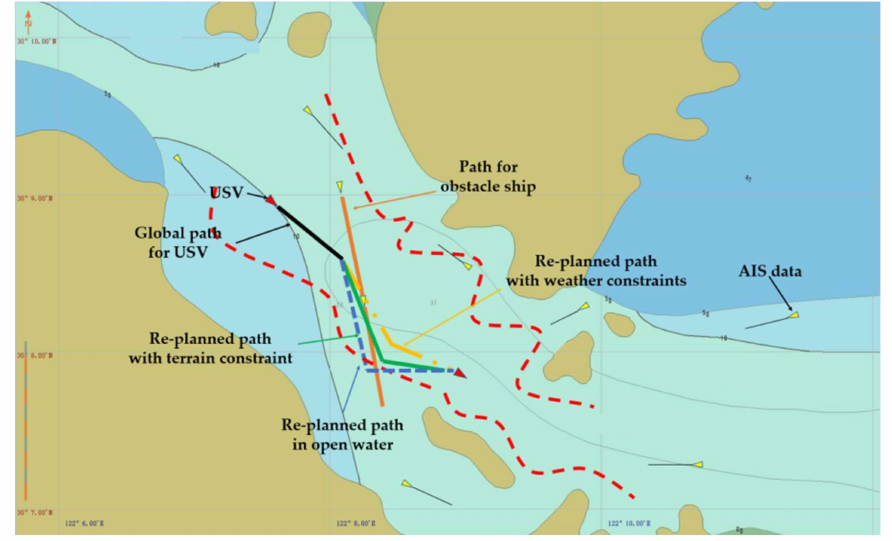
Figure 18. HIL test results for for a representative overtaking encounter in restricted